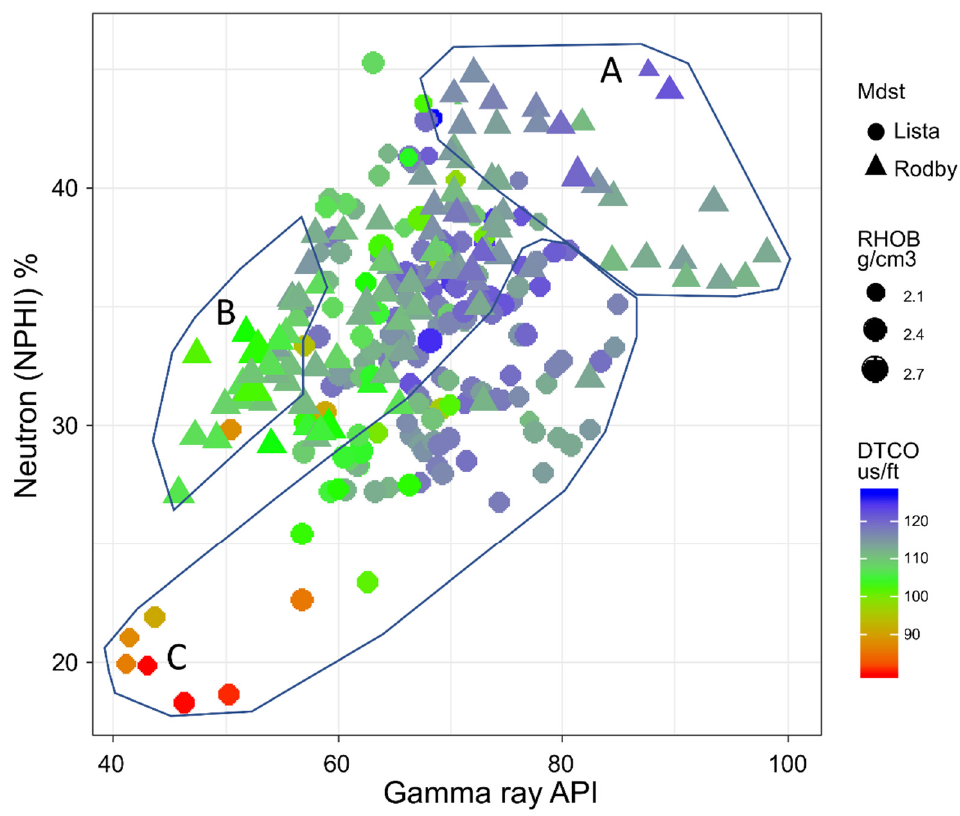
Figure 13. Comparison of the gamma and neutron log data between the Palaeocene Lista Shale (16 / 21-13 and 16 / 21-20; Figures 6 and 7) and the Lower Cretaceous Rodby Shale (14 / 26-1, 14 / 26a-7A and 14 / 26a-8; Figures 3–5), with the data characterised by the density log (RHOB, related to symbol size) and compressional sonic (DTCO related to colour in the rainbow spectrum) log values. Diagram